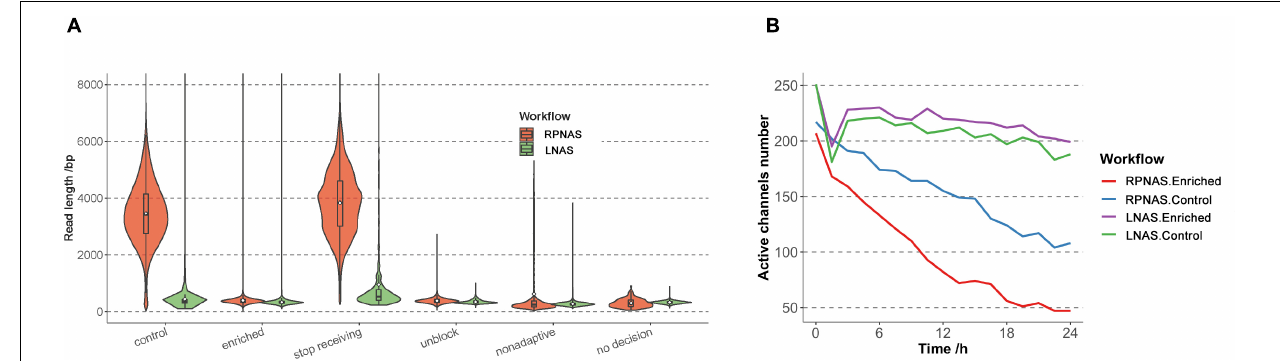
FIGURE 2 | Sequencing performance of the RPNAS and LNAS workflows with pooled samples. (A) Read length distributions with different decisions in two workflows. Reads in RPNAS and LNAS workflow were indicated in red and green, respectively. (B) Changes in the active channel numbers over 24 h of sequencing in different workflows.